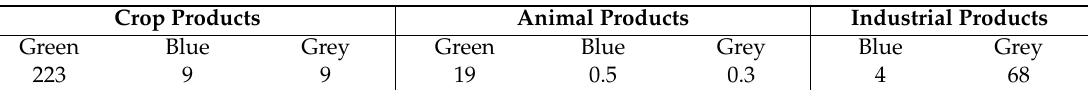
Table 2. Virtual water import to the EU (km 3 /year) by major product groups, average for 2006–2013.